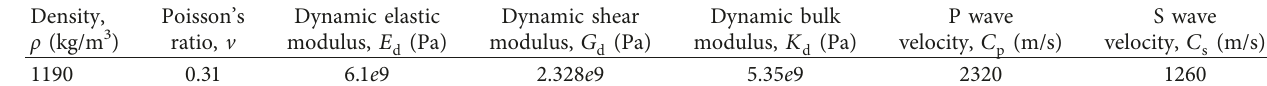
Table 3: Dynamic parameters of PMMA.